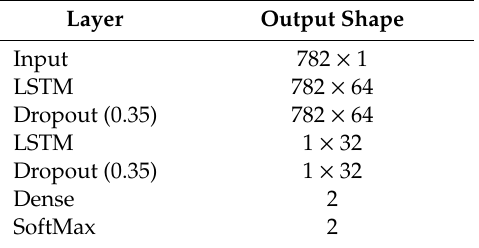
Table 11. Summary of LSTM model configurations in [29].